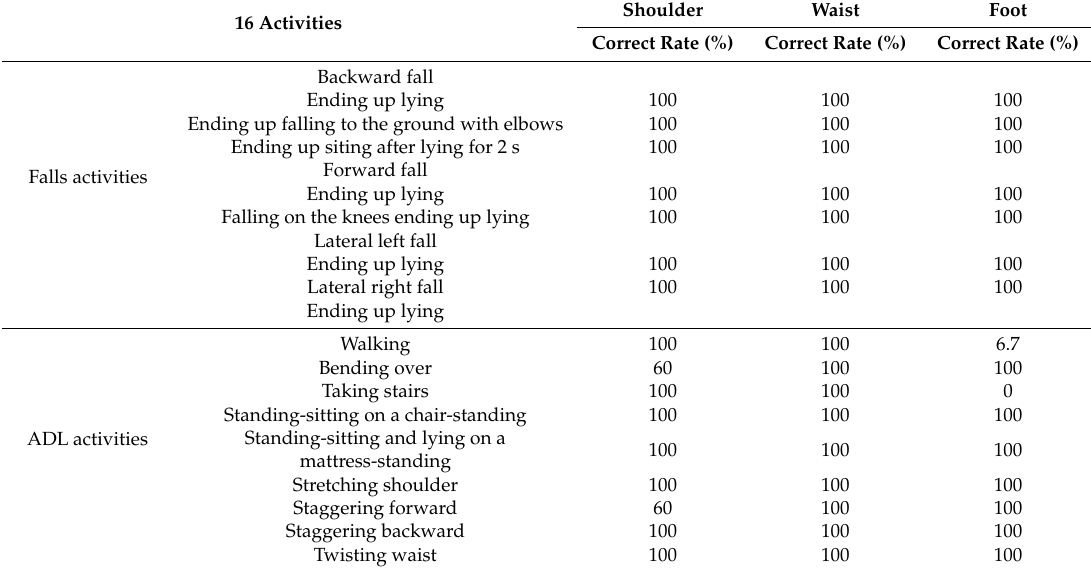
Table 2. Detection accuracy of 16 activities on the three human body segments in the experiment.